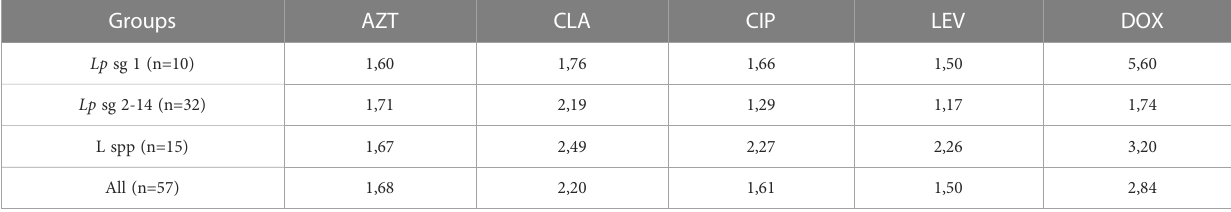
TABLE 3 Ratios comparing automatic to the manual reading of MICs discriminated by serological group of isolates and antibiotic. Groups